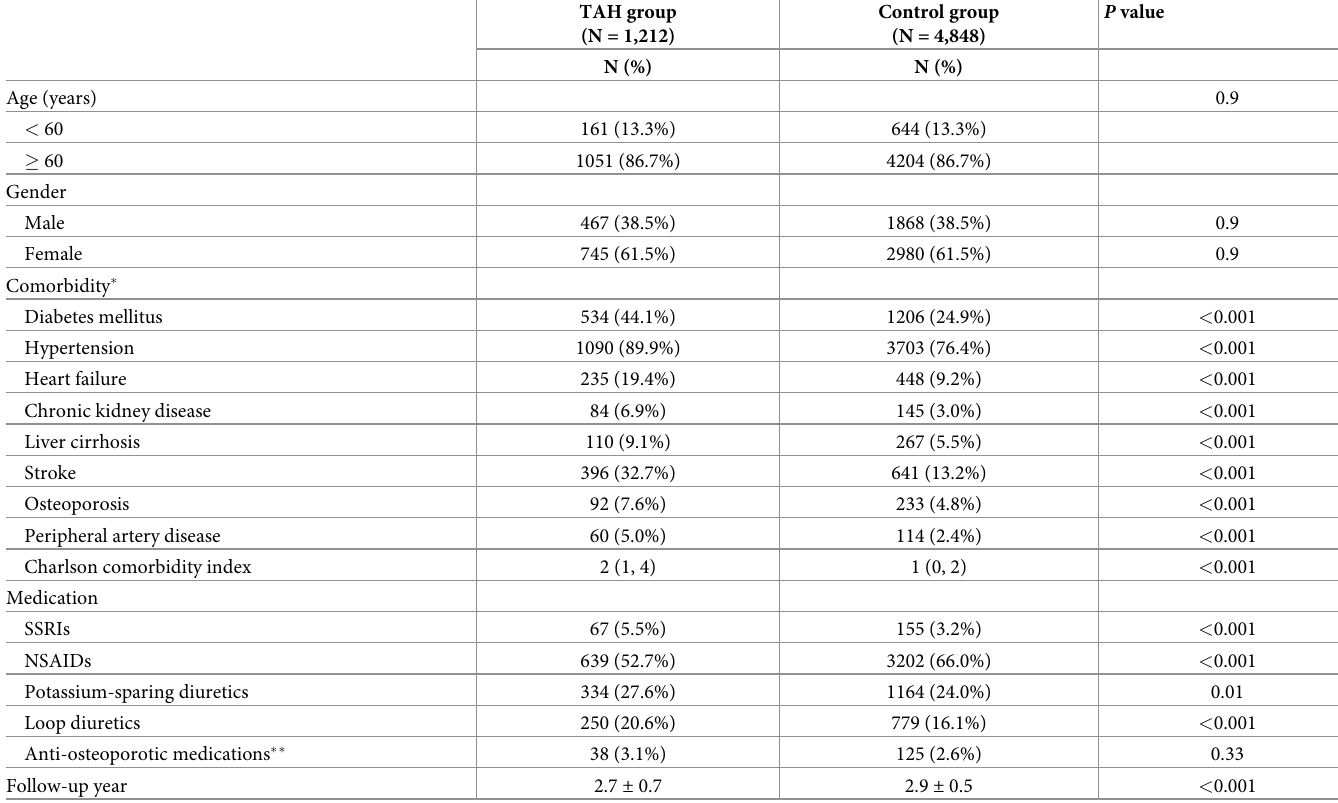
Table 1. Baseline characteristics of study subjects.